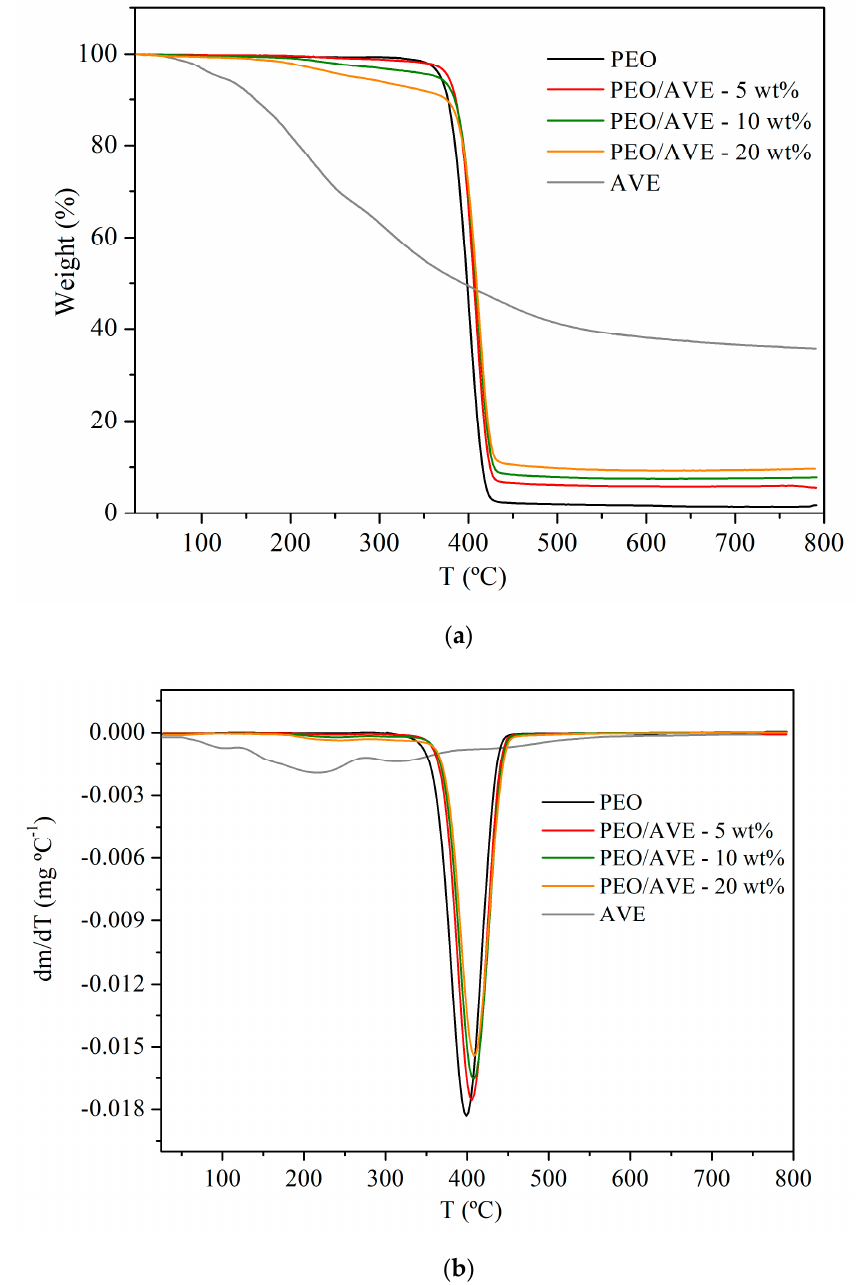
Figure 3. ( a ) TGA and ( b ) DTG thermograms of AVE, and PEO and PEO/AVE nanofibers.